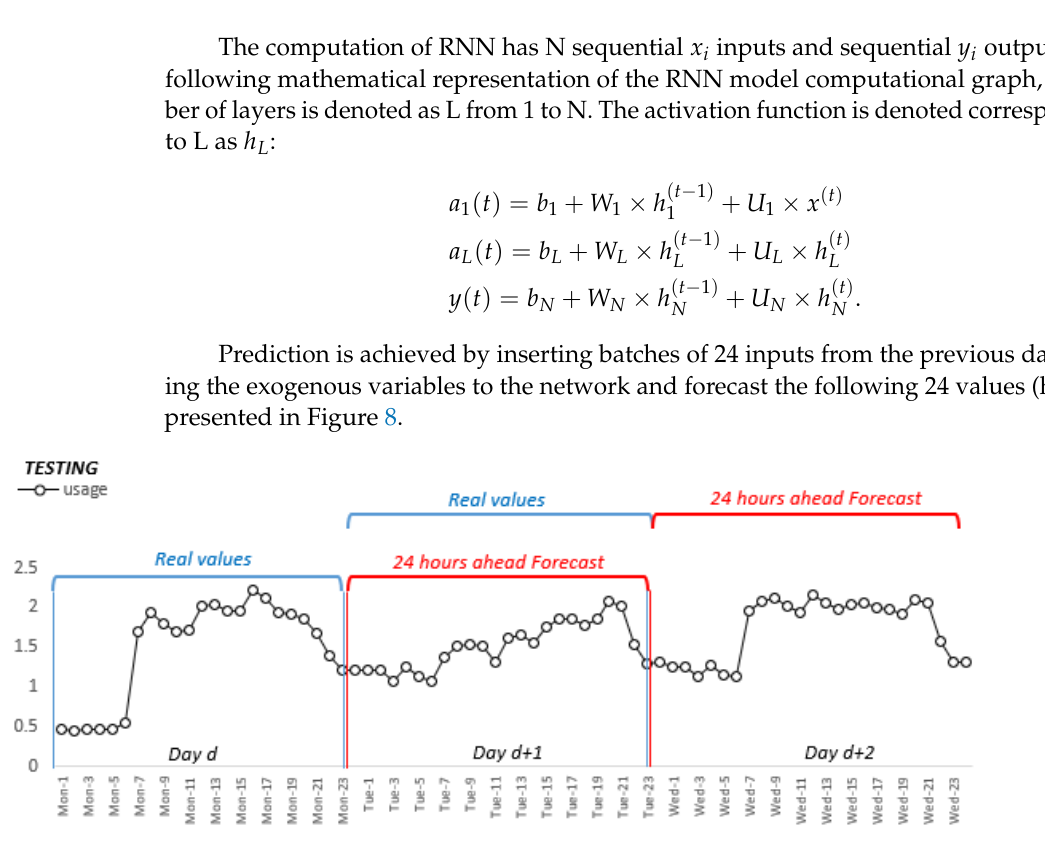
Figure 8. Forecast horizon window for testing data.